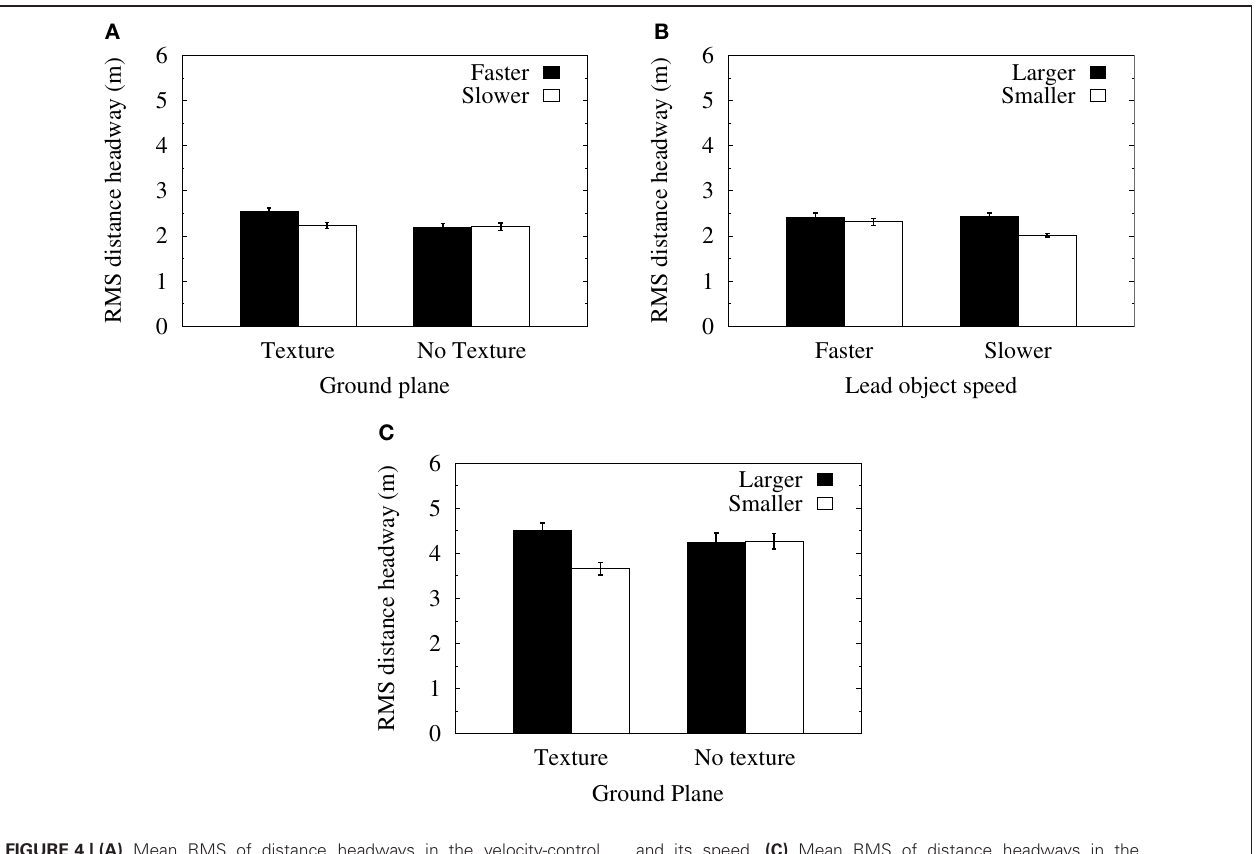
FIGURE 4 | (A) Mean RMS of distance headways in the velocity-control condition as a function of the presence of ground texture and the speed of the lead object. (B) Mean RMS of distance headways in the velocity-control condition as a function of the size of the lead object